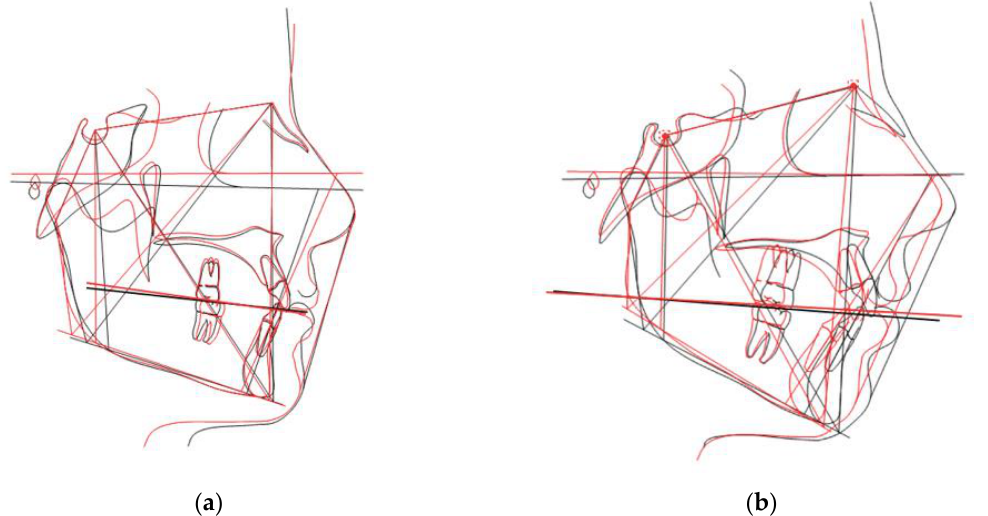
Figure 3. OP changes in ( a ) hypodivergent and ( b ) hyperdivergent patients in which pre-treatment is portrayed in black and post-treatment in red.